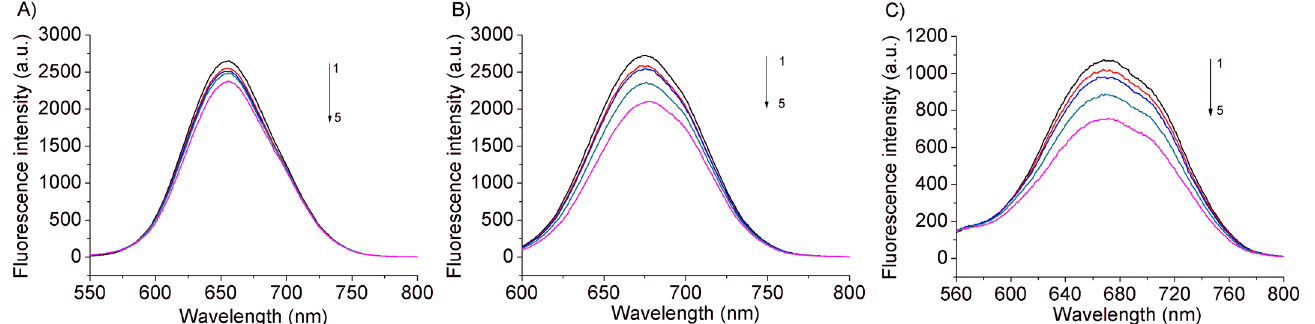
Fig 5. Interaction of the isophorone derivatives with DNA studied using fluorescence spectroscopy. Fluorescence emission spectra of: A) Isoa (15.6 μ M) treated with: 0.0, 9.90, 19,80 47.16, 86.21 μ M (curves 1 – 5) of DNA ( λ exc = 500 nm). B) Isob (15.6 μ M) treated with: 0.0, 9.90, 19.80, 47.16, 86.21 μ M (curves 1 – 5) of DNA ( λ exc = 515 nm). C) Isoc (15.6 μ M) treated with: 0.0, 9.90, 19.80, 47.16, 86.21 μ M (curves 1 – 5) of DNA ( λ exc = 510 nm). All the experiments were carried out at room